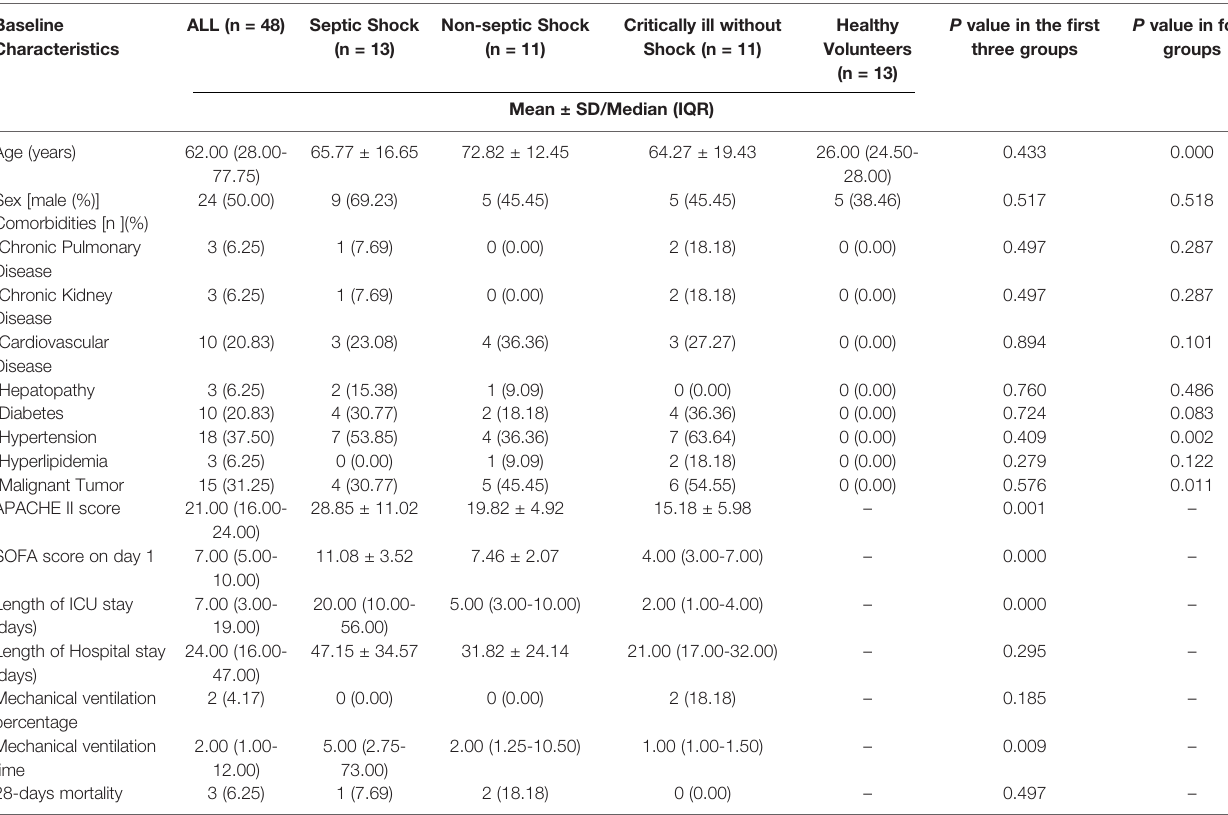
TABLE 1 | Baseline characteristic of ICU patients and healthy